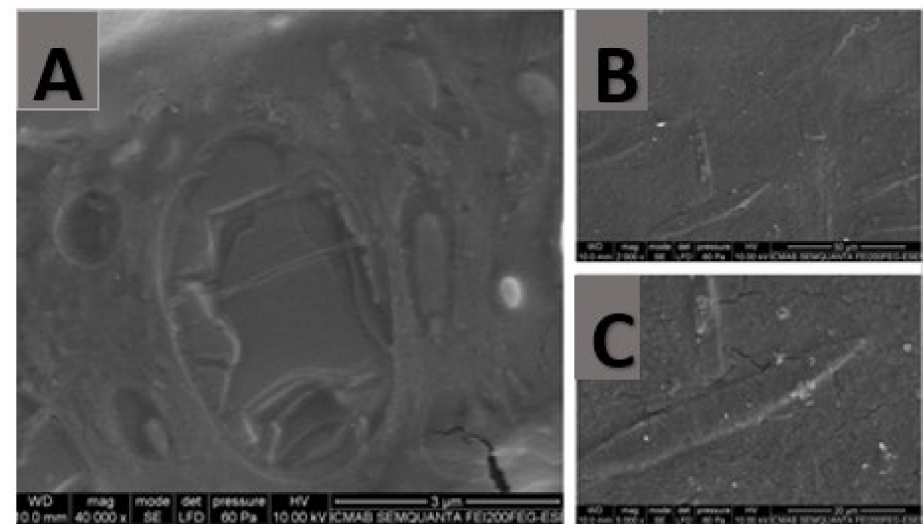
Figure 2. SEM images of sodium alginate and hyaluronic acid gel with 2% KT. ( A ) Magnification 40.000 × , scale bar 3 µ m; ( B ) magnification 2.000 × , scale bar 50 µ m; ( C ) magnification 5.000 × , scale bar 20 µ m.